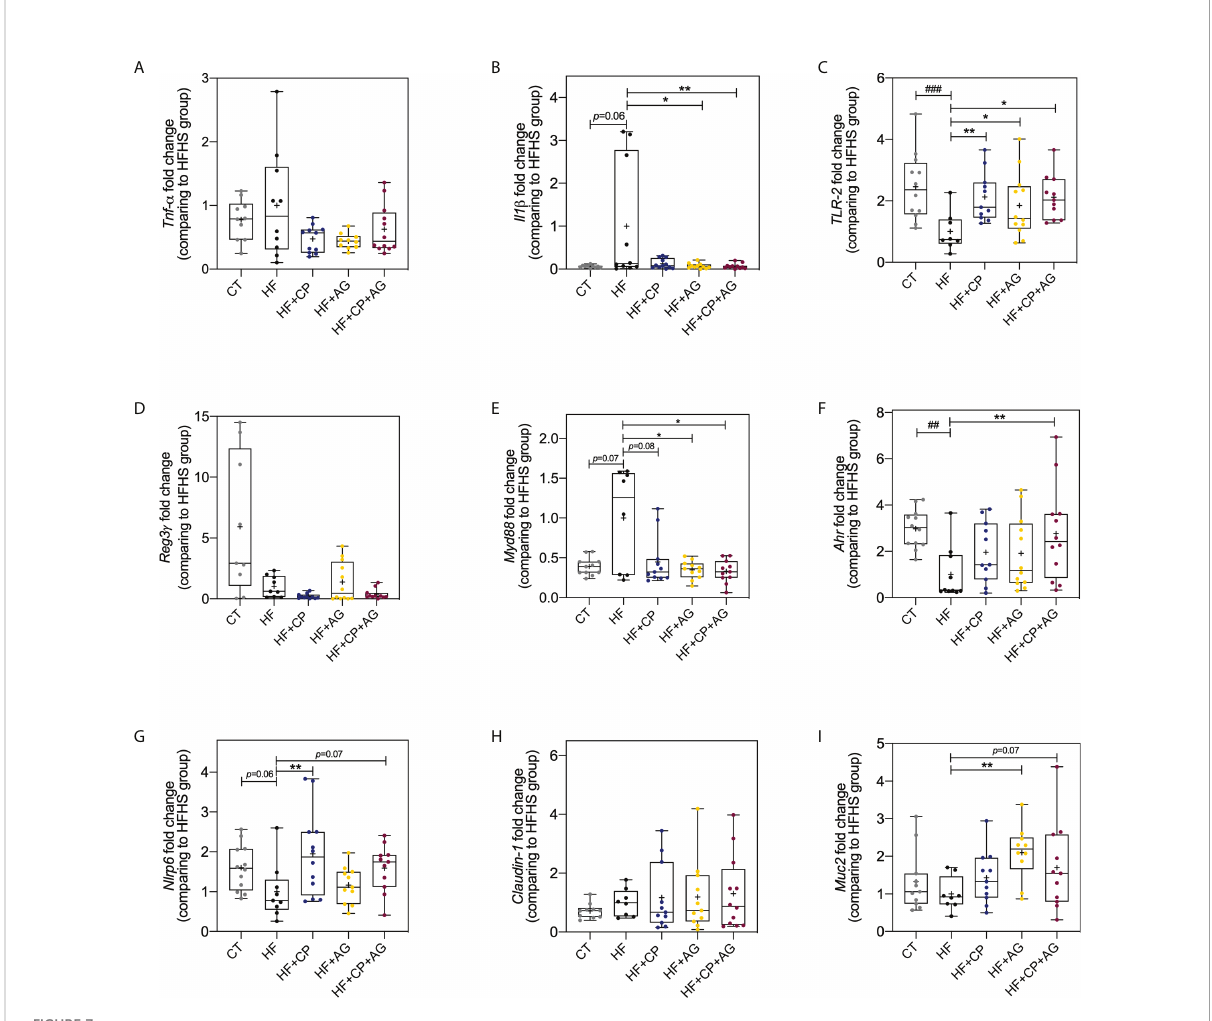
FIGURE 7 Effects of cranberry polyphenols and agavins in the relative expression of genes linked to the control of gut epithelial barrier function and in fl ammation. The fold change of colonic gene expression relative to HFHS-fed mice (normalized to 1.0) of (A) tumor necrosis factor-alpha ( Tnf a ) ; (B) interleukin 1 beta ( Il1 b ) ; (C) Toll-like receptor 2 ( Tlr2 ); (D) regenerating islet-derived protein 3 gamma ( Reg-3- g ); (E) myeloid differentiation primary response 88 ( Myd88 ); (F) aryl hydrocarbon receptor ( Ahr ); (G) NOD-like receptor family pyrin domain containing